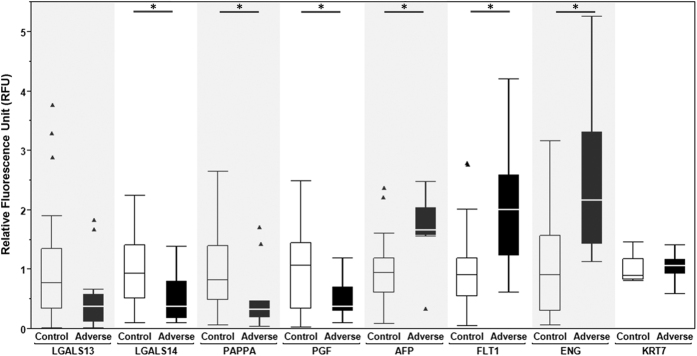
Box-and-whisker plot showing the distribution of normalized Relative Fluorescence Unit values of each candidate protein biomarker for control (white boxes) and adverse outcome (black boxes) patients.The boxes represent the 25th to 75th percentiles, and horizontal lines within the boxes indicate the medians. The whiskers are drawn to indicate 1.5 × Inter Quartile Range (3rd quartile – 1st quartile). The triangles represent outliers. *p < 0.05 between control and adverse cohorts for each protein. For KRT7, N = 9 for control, N = 8 for adverse. For all other proteins, N = 29 for control, N = 12 for adverse.